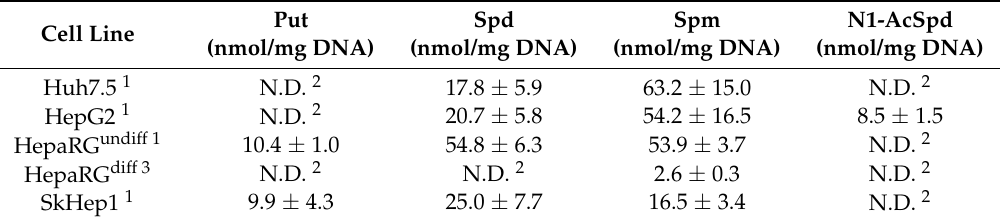
Table 1. Polyamine levels in cell lines.